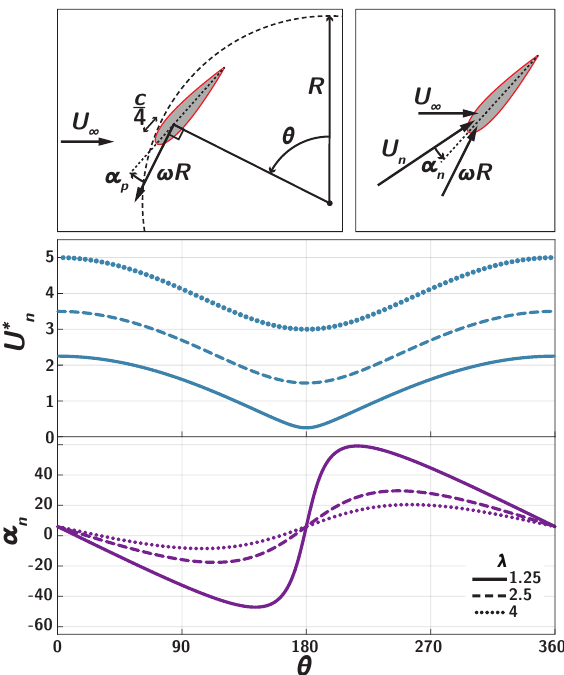
Fig. 1. Top left, schematic definitions of the blade pitch angle, α p , as measured at the quarter chord, c/ 4 , the azimuthal blade position, θ , and the r . The zero position, θ = 0 , is defined rotational velocity vector, ωr = dθ dt for the foil traveling directly upstream. The top right defines the vector sum of the freestream velocity and the angular velocity as the nominal velocity, U n . Center plot: The nominal velocity profiles for a turbine operating at three constant tip-speed ratios. Bottom: The nominal angle of attack profiles for the same three tip-speed